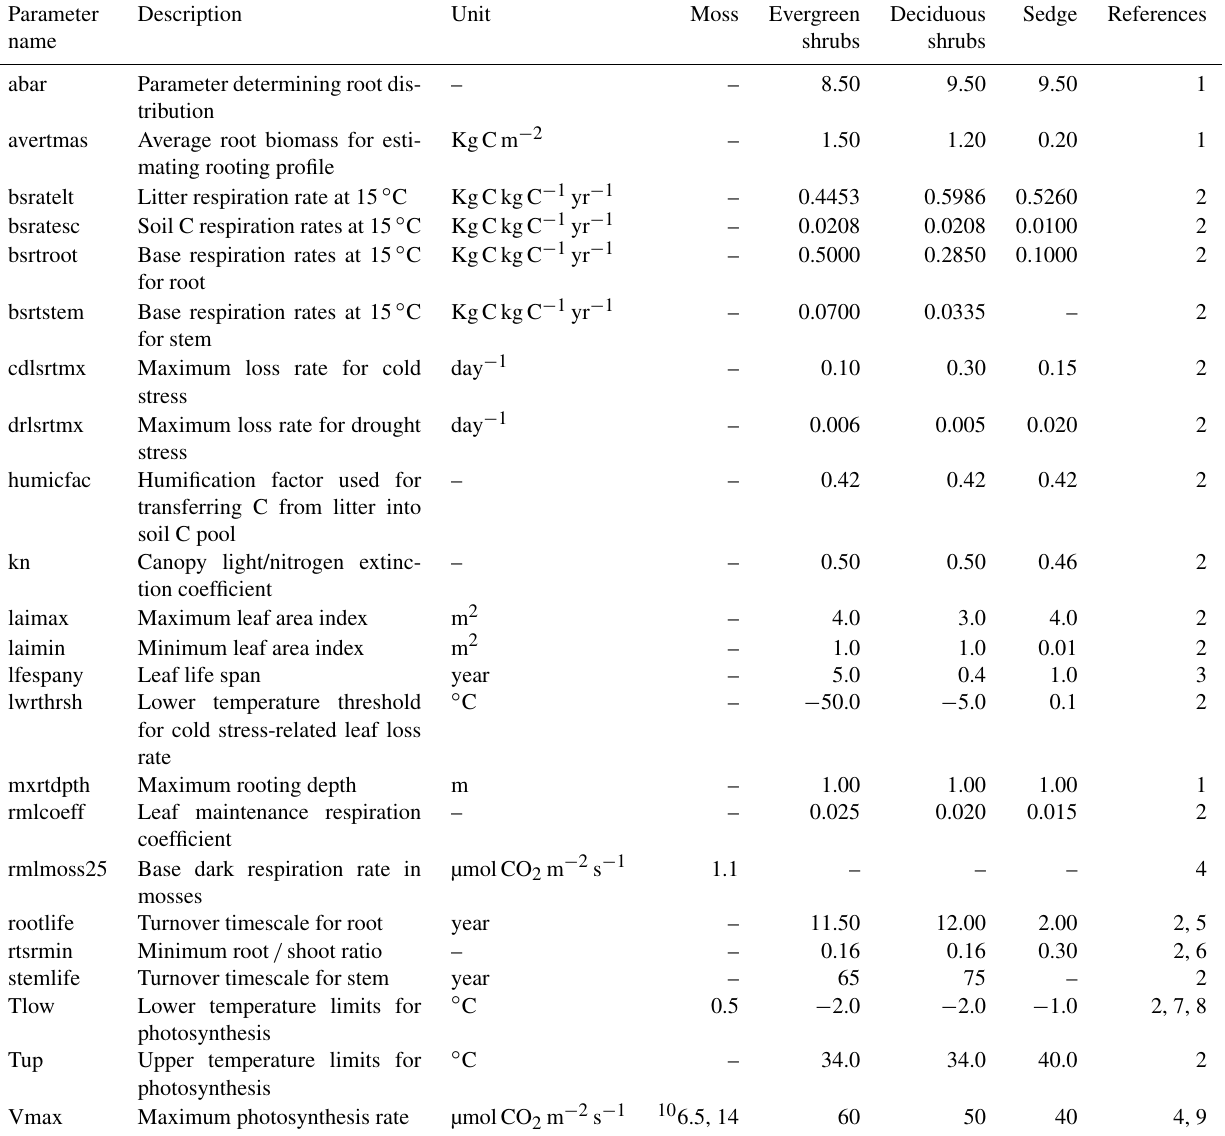
Table 2. Descriptions of vegetation characteristics for the four peatland PFTs. A dash (–) indicates the parameter is inapplicable to that PFT.